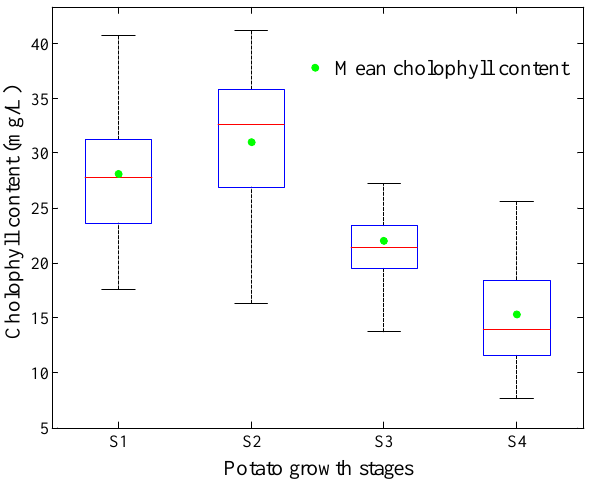
Figure 2. Statistical box line graph of chlorophyll content during potato growth stage.